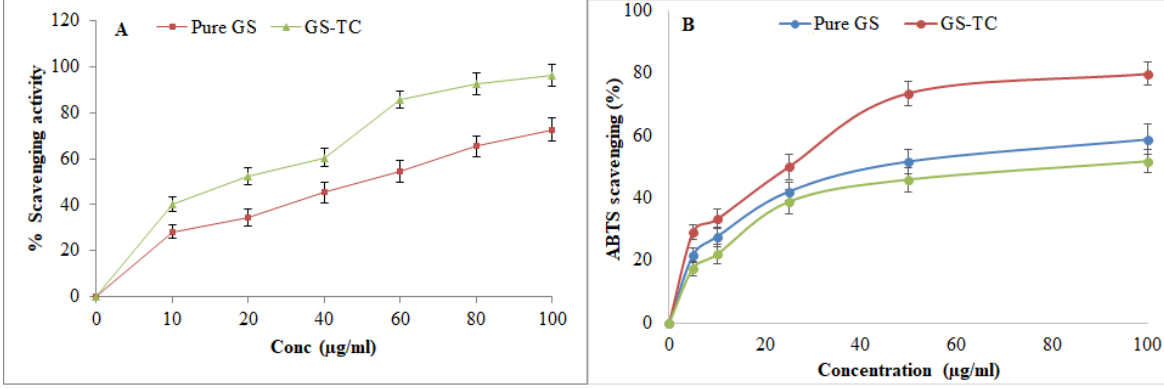
Figure 10. ( A ) DPPH method, ( B ) ABTS scavenging method, Antioxidant results of Genistein (GS) and genistein ternary complex (GS-TC). The data shown as mean ± SD (n=3).